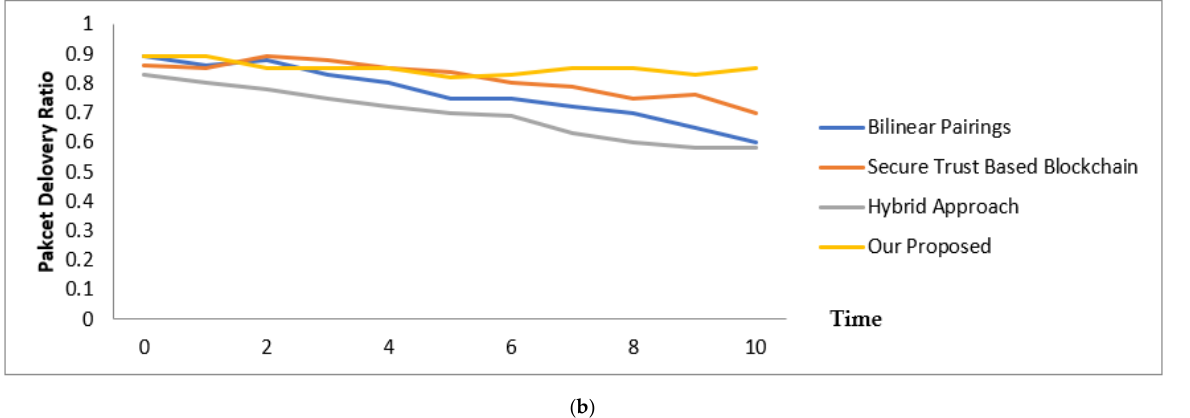
Figure 7. ( a ): Average Packet Delivery Ratio with DDoS Attack w.r.t No. of Nodes; ( b ): Average Packet Delivery Ratio with DDoS Attack w.r.t Time.